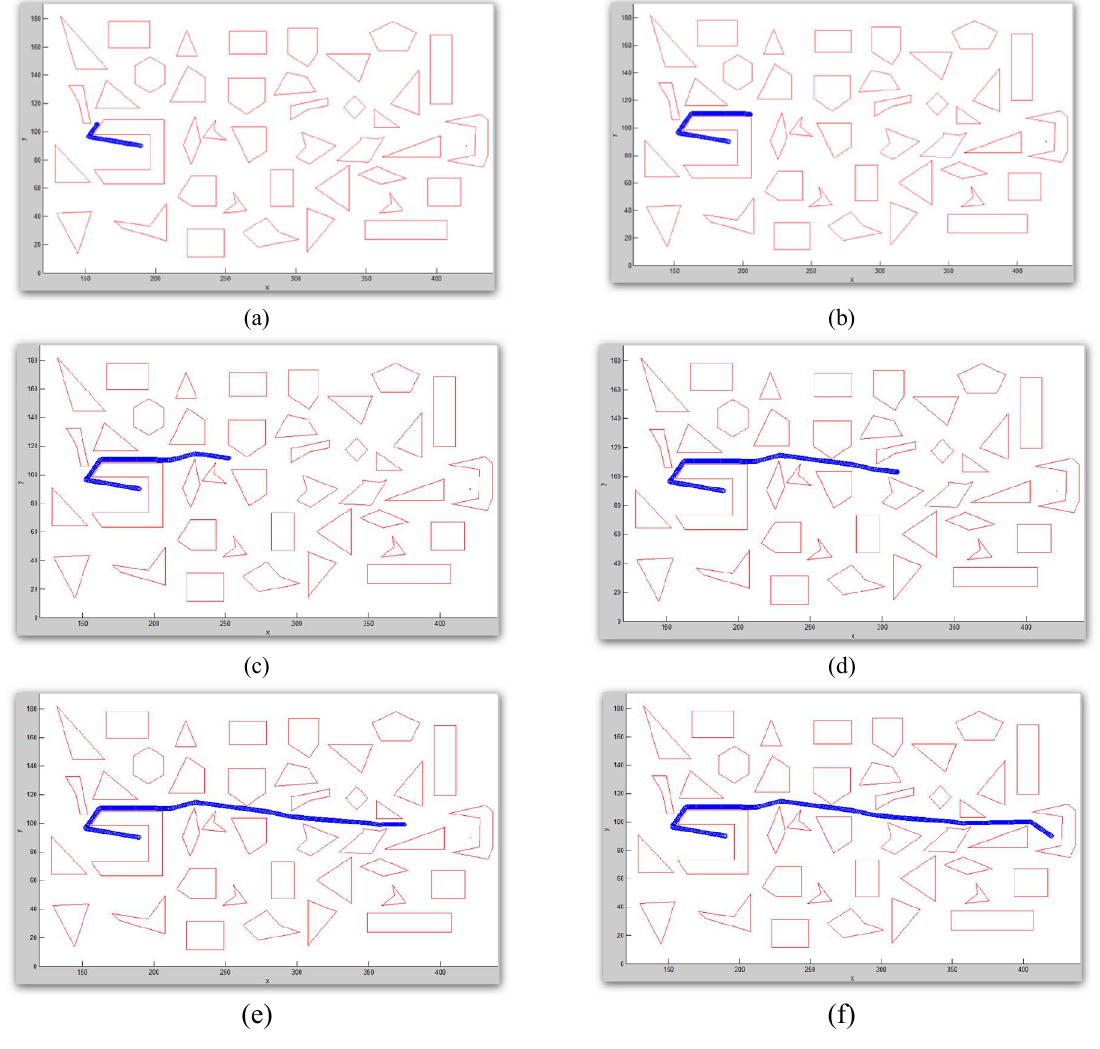
Fig. 9. The efficiency of SPP algorithm in a complex